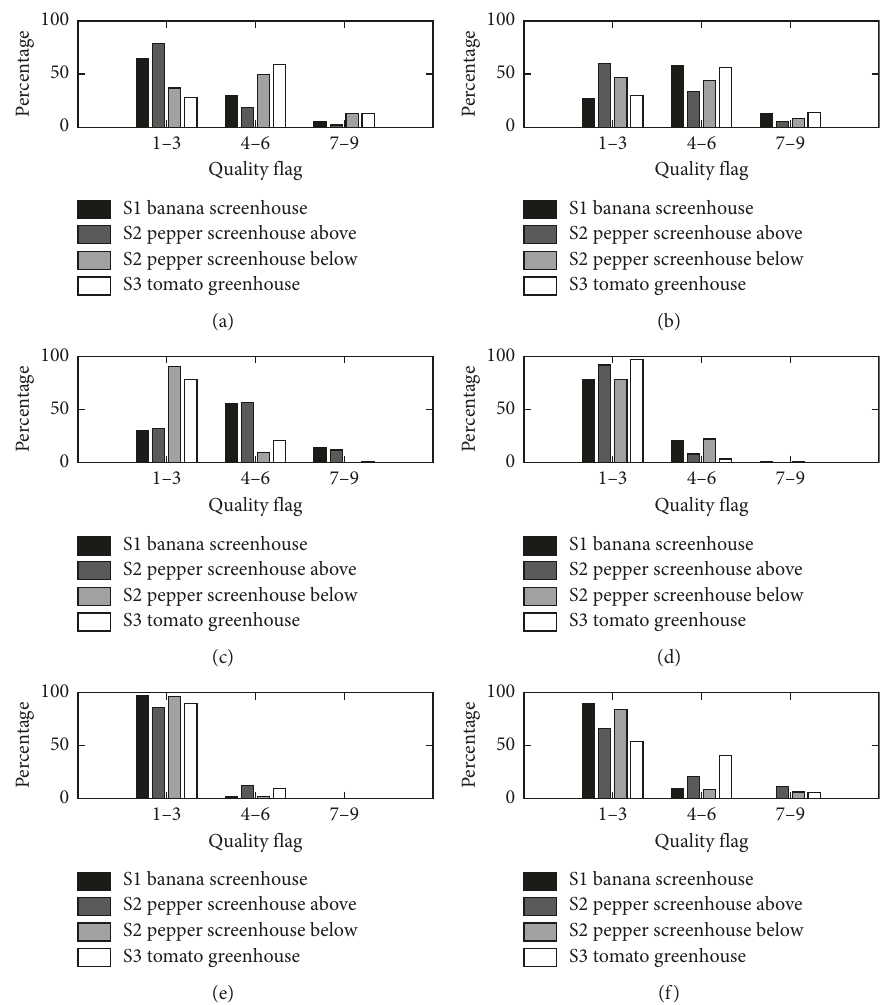
Figure 2: Results of quality control tests: the percentage of data points within each range of quality category:1–3 (research), 4–6 (flux data), and 7–9 (orientation). (a) Steady-state test: Cov ( w Table 4: Summary of data quality control.